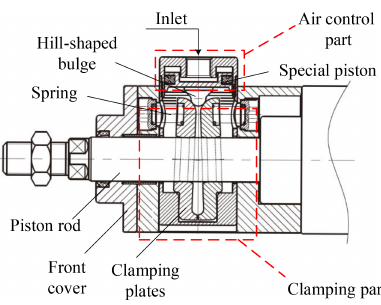
Figure 4. The structure of the pneumatic locking mechanism.